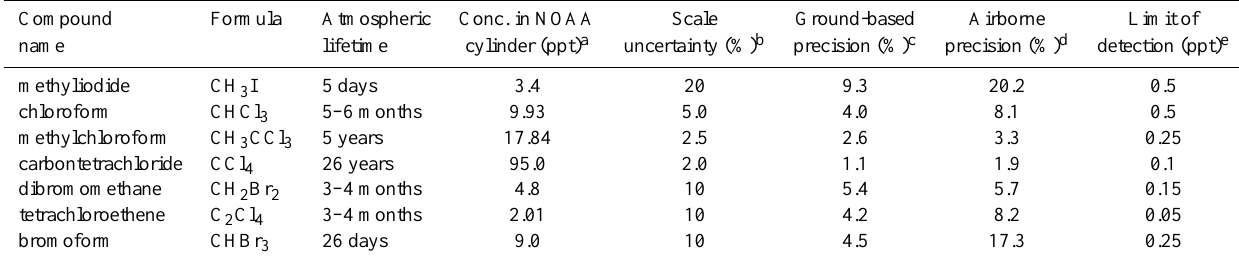
Table 1. µ Dirac target compounds and measurement performance during the Cape Verde ground-based and aircraft campaign. Compound Formula Atmospheric Conc. in NOAA Scale Ground-based Airborne Limit of name lifetime cylinder (ppt) a uncertainty (%) b precision (%) c precision (%) d detection (ppt) e methyliodide CH 3 I 5 days CHCl 3 methylchloroform carbontetrachloride CCl 4 26